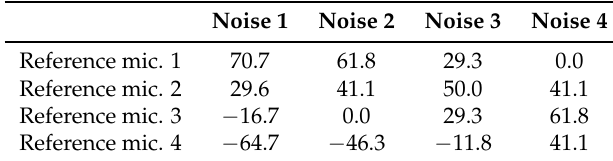
Table 1. Differences in distance between primary path and reference path [cm].